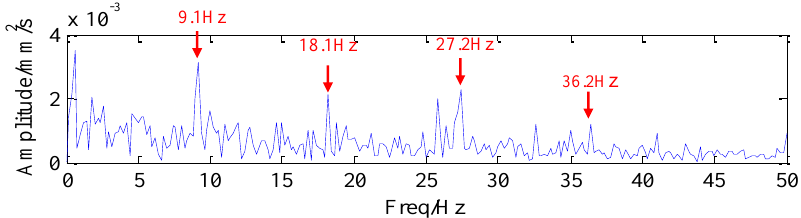
Figure 19. Spectrum of the filtered signal.